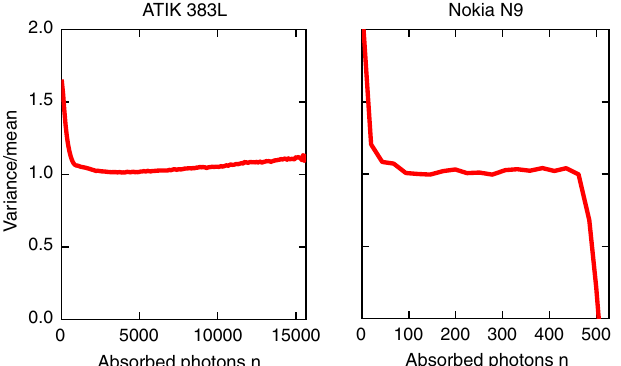
FIG. 4. Fano factor (variance/mean) of the devices employed in this experiment. We operate in the region where the Fano factor is 1 and the detector is most